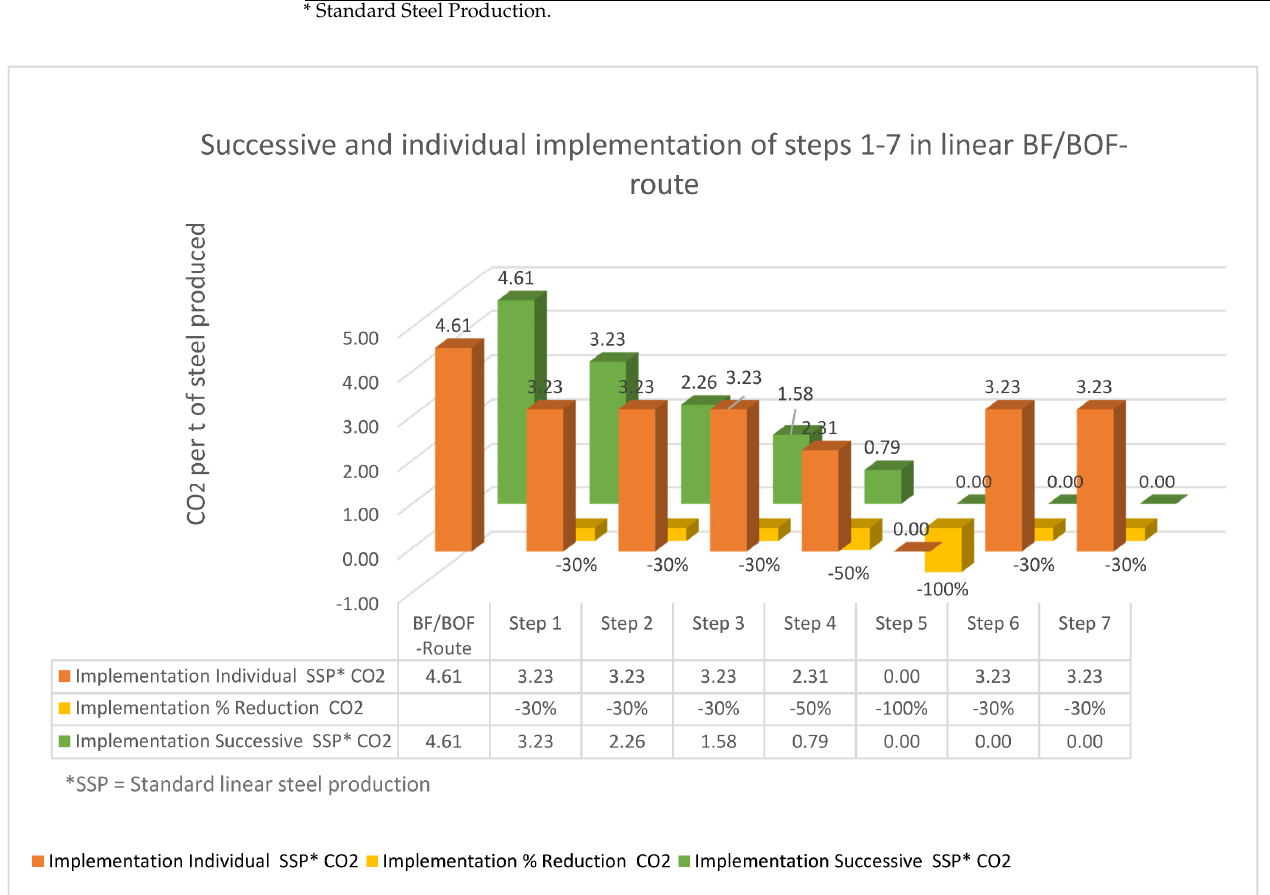
Figure 7. Individual and successive implementation of Steps 1–7.